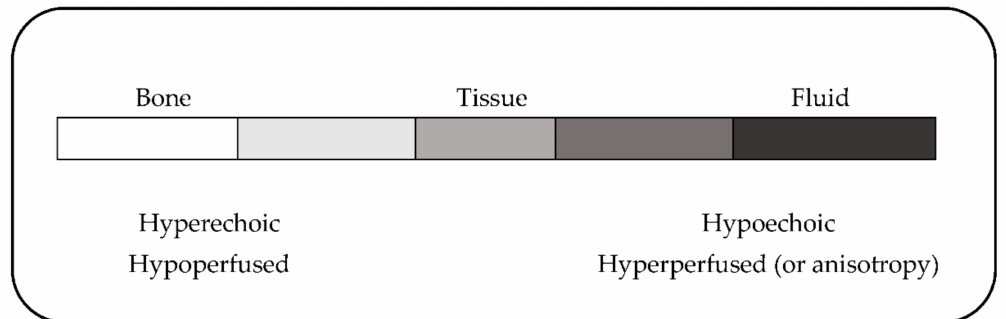
Figure 1. Illustration of musculoskeletal ultrasound interpretation. Note that fluid is always black andtissue is always grey. Bone, being the densest tissue, and least perfused will appear the brightest grey/white. Trigger points are consistently imaged as hypoechoic and therefore, barring anisotropy/image error, must be